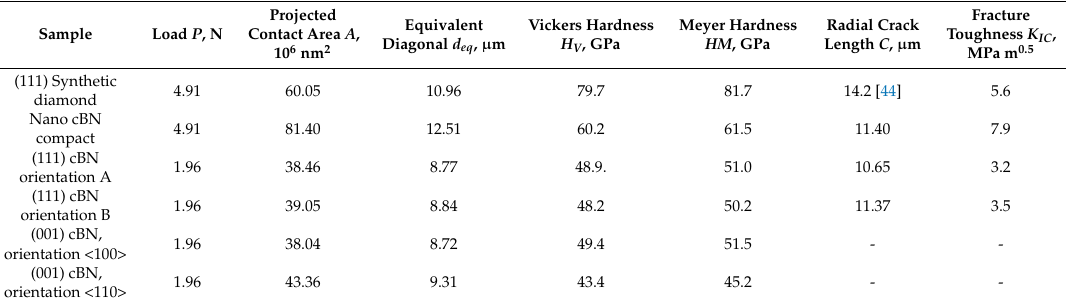
Table 2. Vickers and Meyer hardness of diamond and cBN measured taking into account the elastic deformation of the Vickers diamond indenter and the concave shape of